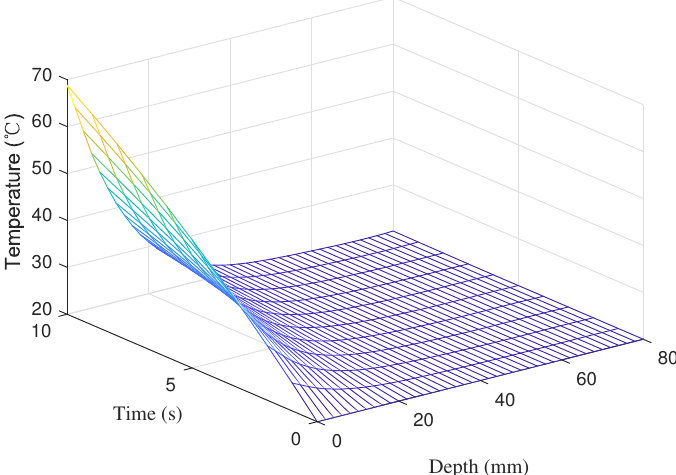
Figure 7. The global temperature distribution calculated by the proposed method at x = x 0 /2.